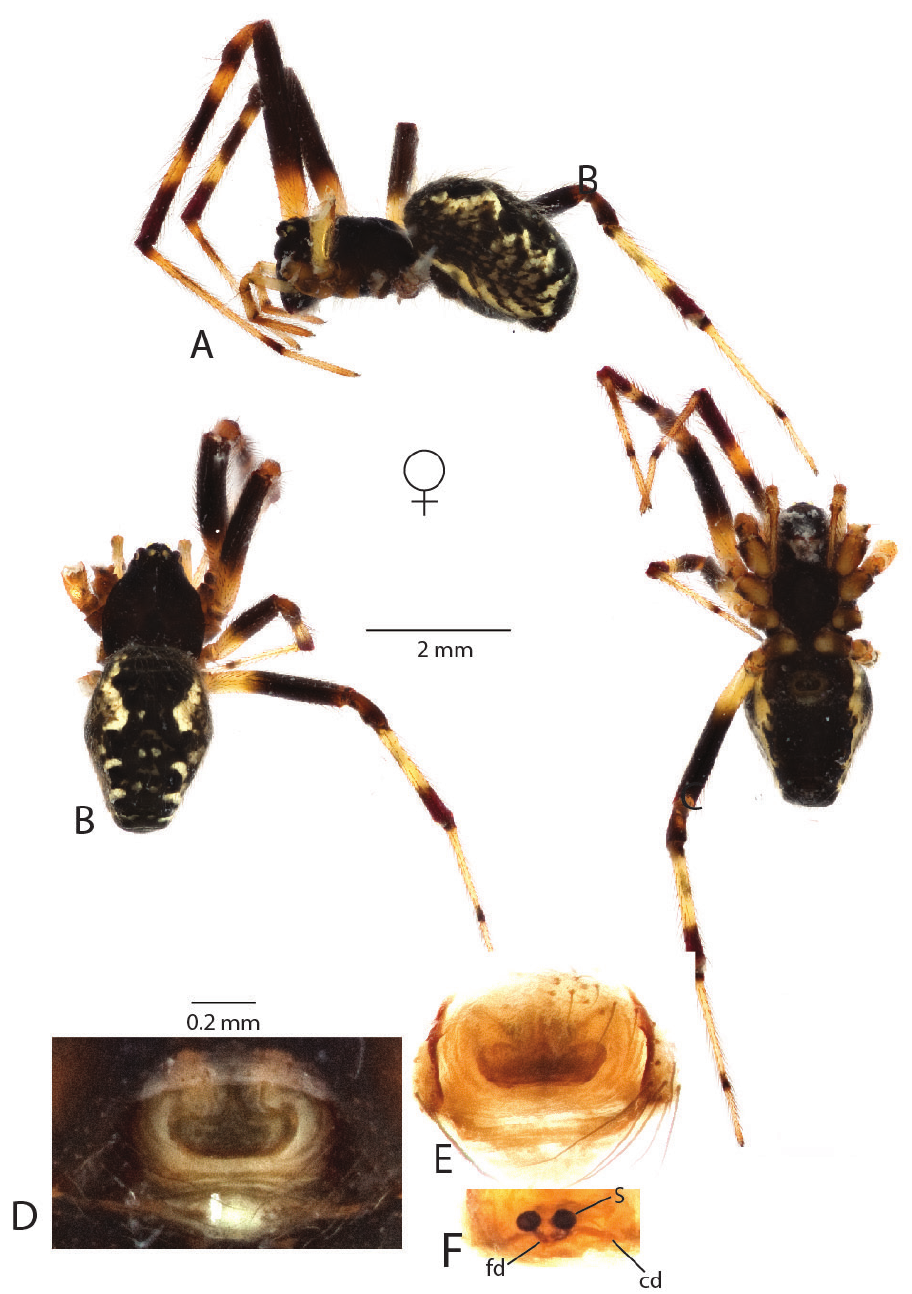
Figure 7. Anelosimus torfi : A–C female lateral, dorsal, ventral D epigynum ventral view E–F cleared epigynum, ventral,